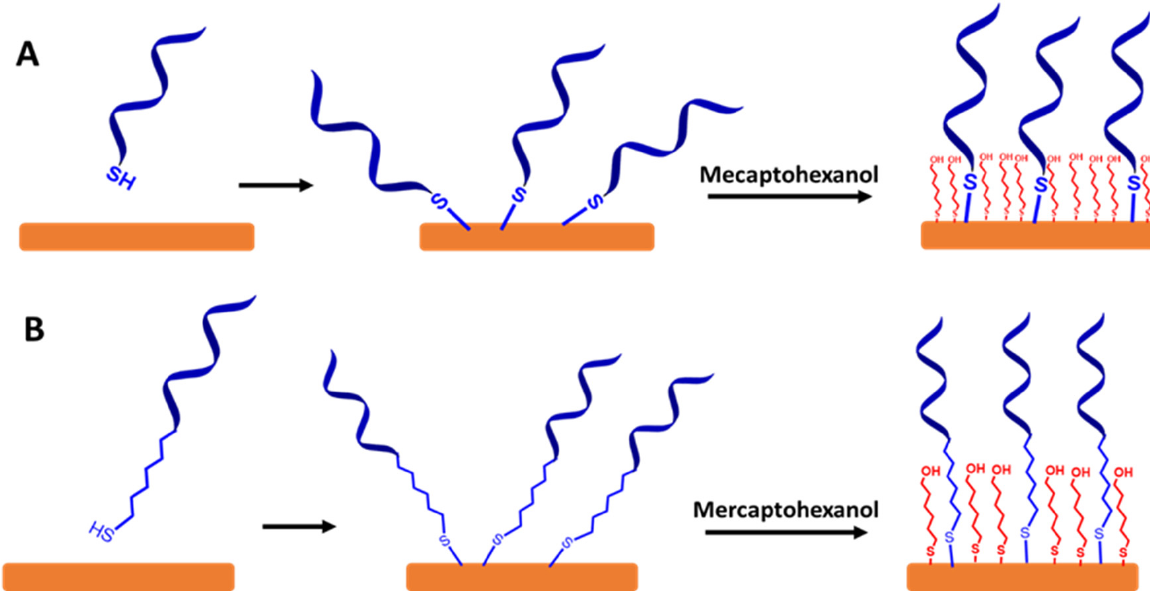
Figure 7. A schematic representation for a self-assembled monolayer of ssDNA probes on the gold electrode surfaces via thiol chemistry. It is followed by capping the surface with mercaptohexanol. ( A ) Self-assembled monolayer of functionalized thiol ssDNA chains and ( B ) self-assembled monolayer of functionalized thiol-alkyl ssDNA chains. Relative sizes of gold electrodes, ssDNA chains, alkyl ssDNA chains, and mercaptohexanol are not to scale.